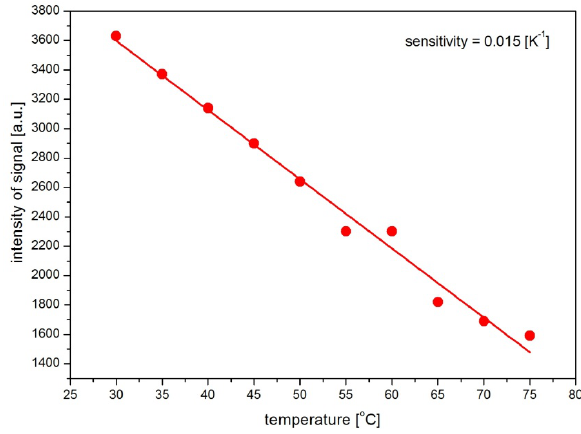
Figure 3: 4 F 3/2 → 4 F 9/2 luminescence intensity versus